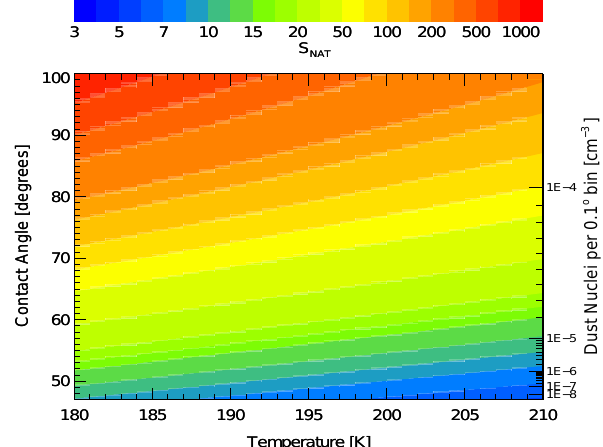
Fig. 1. Supersaturation needed for NAT nucleation for each 0.1 ◦ wide contact angle bin displayed as function of contact angle and temperature derived from Hoyle et al. (2013). The second vertical axis shows the corresponding number of dust particles per